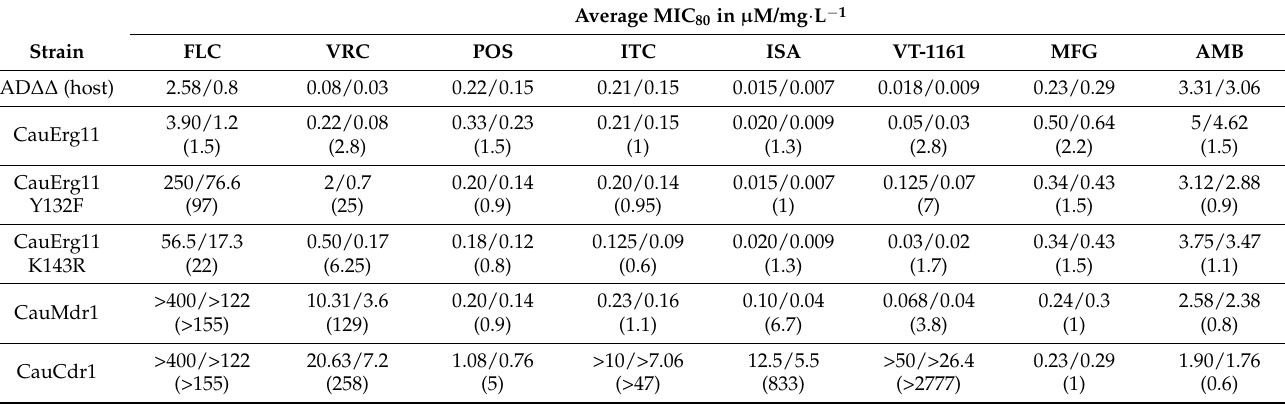
Table 2. Susceptibilities of the host and recombinant strains developed in this